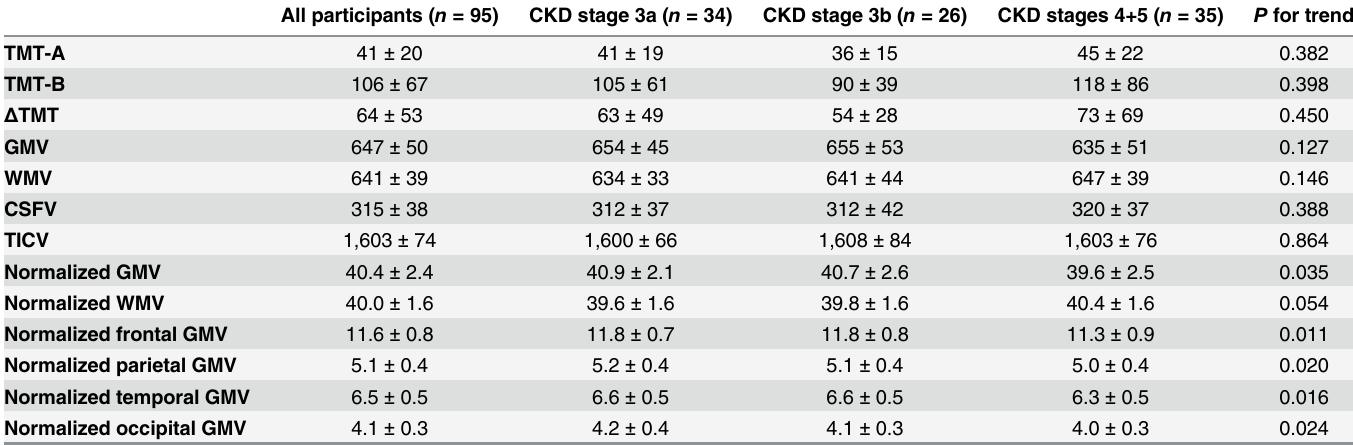
Table 2. TMT Scores and MRI measurements of All Participants According to CKD Stages. Abbreviations: CSFV, cerebrospinal fluid volume; GMV, gray matter volume; TICV, total intracranial volume; TMT, Trail Making Test; WMV, white matter